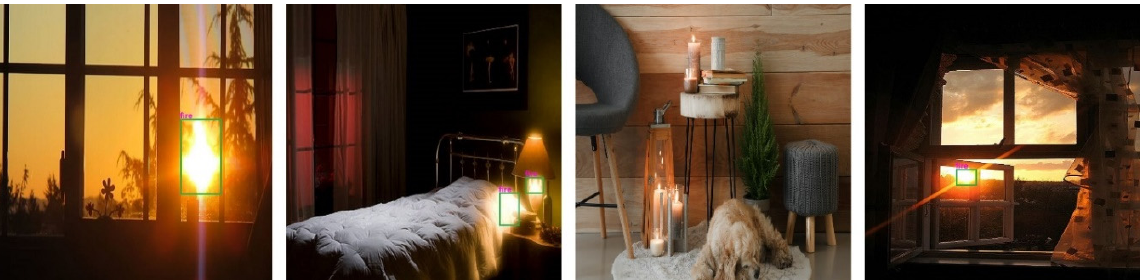
Figure 12. Experimental results showing limitations of the proposed fire detection system.